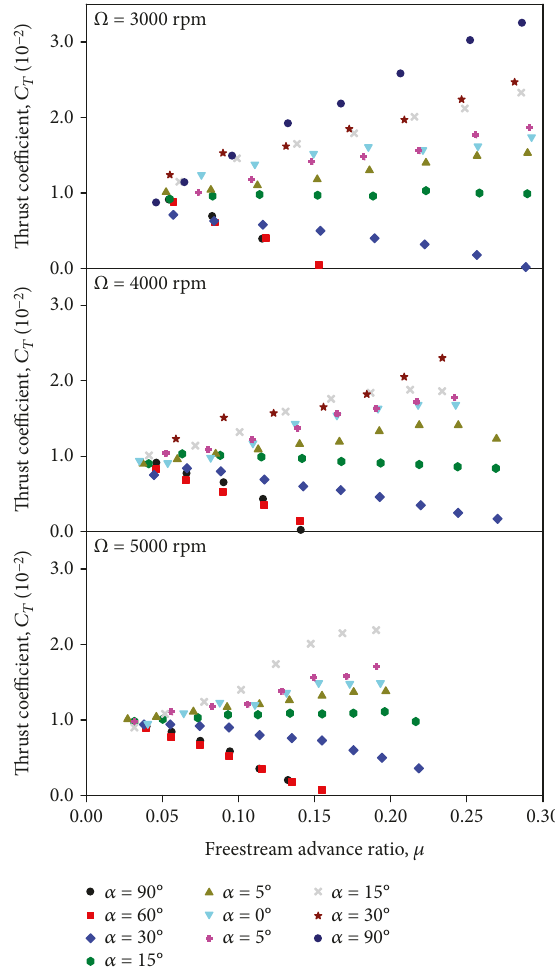
Figure 9: Thrust coe ffi cient for T-motor 18x6.1 at various uncorrected angles of attack under di ff erent rotational